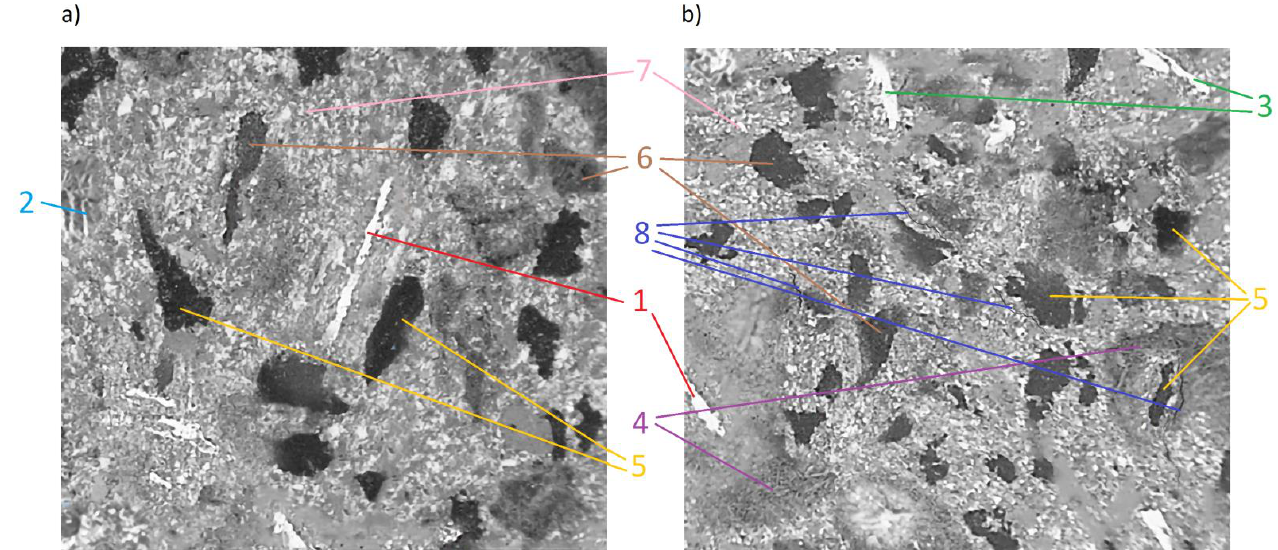
Figure 11. SEM micrograph of samples from same group: ( a ) 10% wear; ( b ) 80% wear. 1 — steel fiber; 2 — glass fiber; 3 — cast iron fiber; 4 — zeolites; 5 — graphite; 6 — rubber; 7 — barite; 8